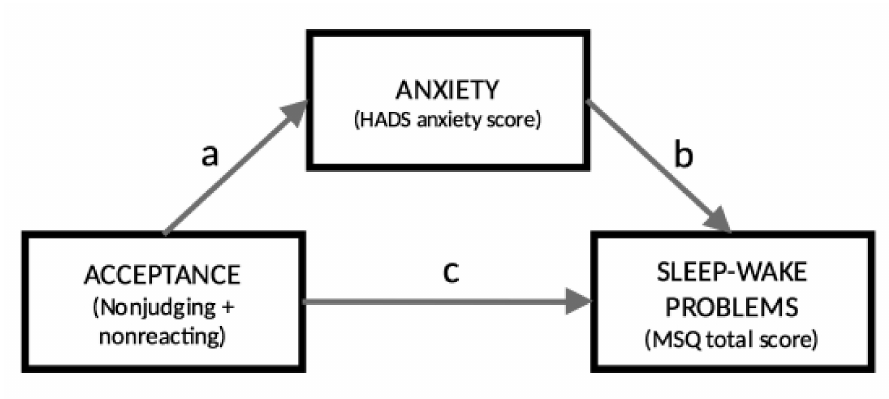
Figure 1. The tested mediation model.